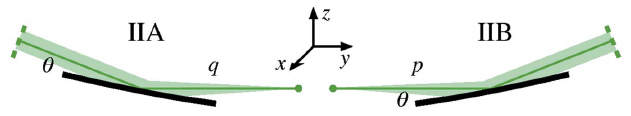
Figure 4 The Type IIA paraboloid focuses a collimated beam to a distance q with the reflected central ray parallel to the y -axis. Type IIB collimates light from a point source at distance p with the incident ray along the y